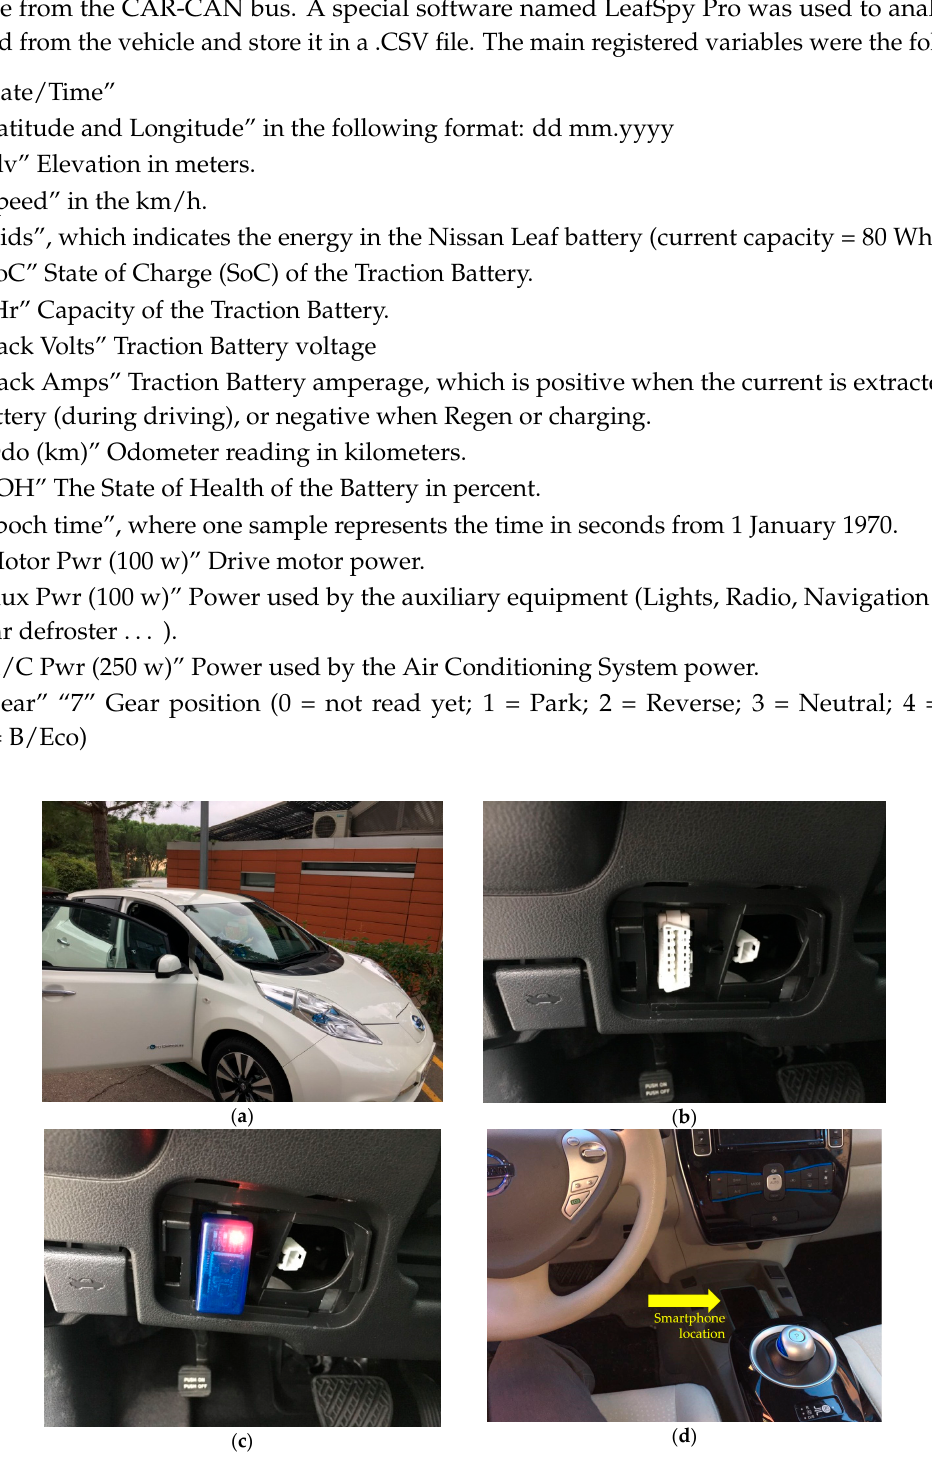
Figure 6. ( a ) 2016 Nissan Leaf. ( b ) Location of the OBD port ( c ) Installation of the Bluetooth OBDII scanner ( d ) Smartphone location inside the vehicle during the